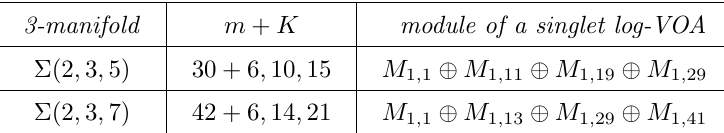
Table 3 . Weil representations and the corresponding modules of the logarithmic (1 ; p ) singlet CFT for simple homology spheres. The sum over modules is precisely the sum over elements of the orthogonal group O m introduced above